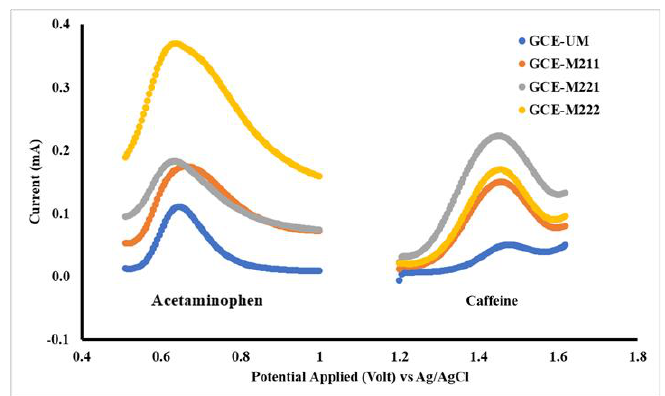
Figure 3. Differential pulse voltammetry (DPV) voltammograms for acetaminophen and